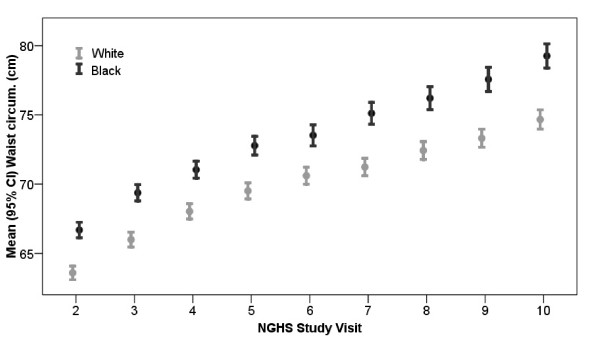
Waist circumference by study visit. Cross-sectional comparisons of mean waist circumference and 95% confidence intervals by race and visit